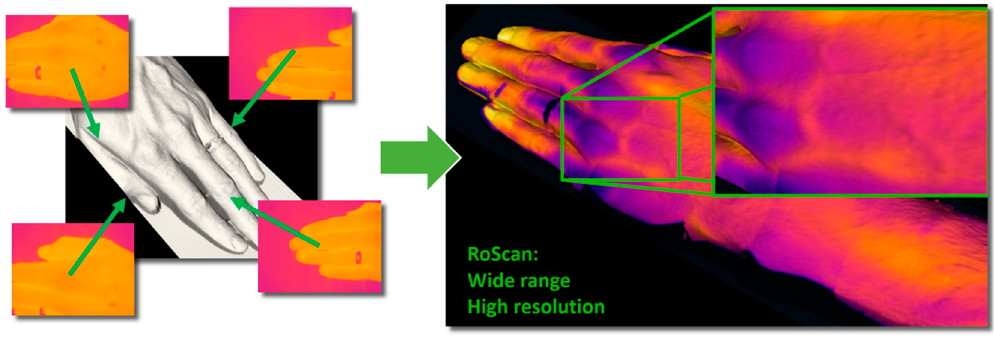
Figure 9. The resolution vs. range problem: combining multiple images with the RoScan delivers a wide range and a high resolution simultaneously.